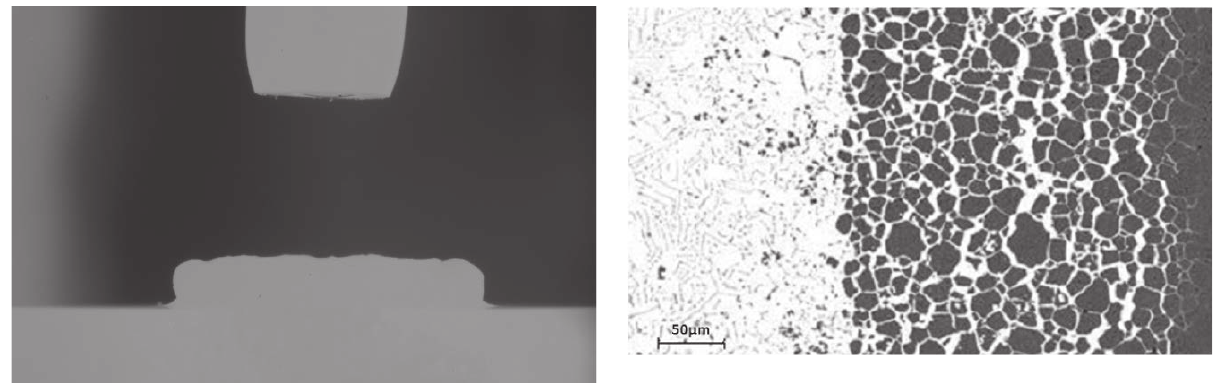
Fig. 7: SEM-BSE image of the interface and penetration zone from experiment 10 FeNi9 (10 min). Alloy phase white, TiC phase dark.